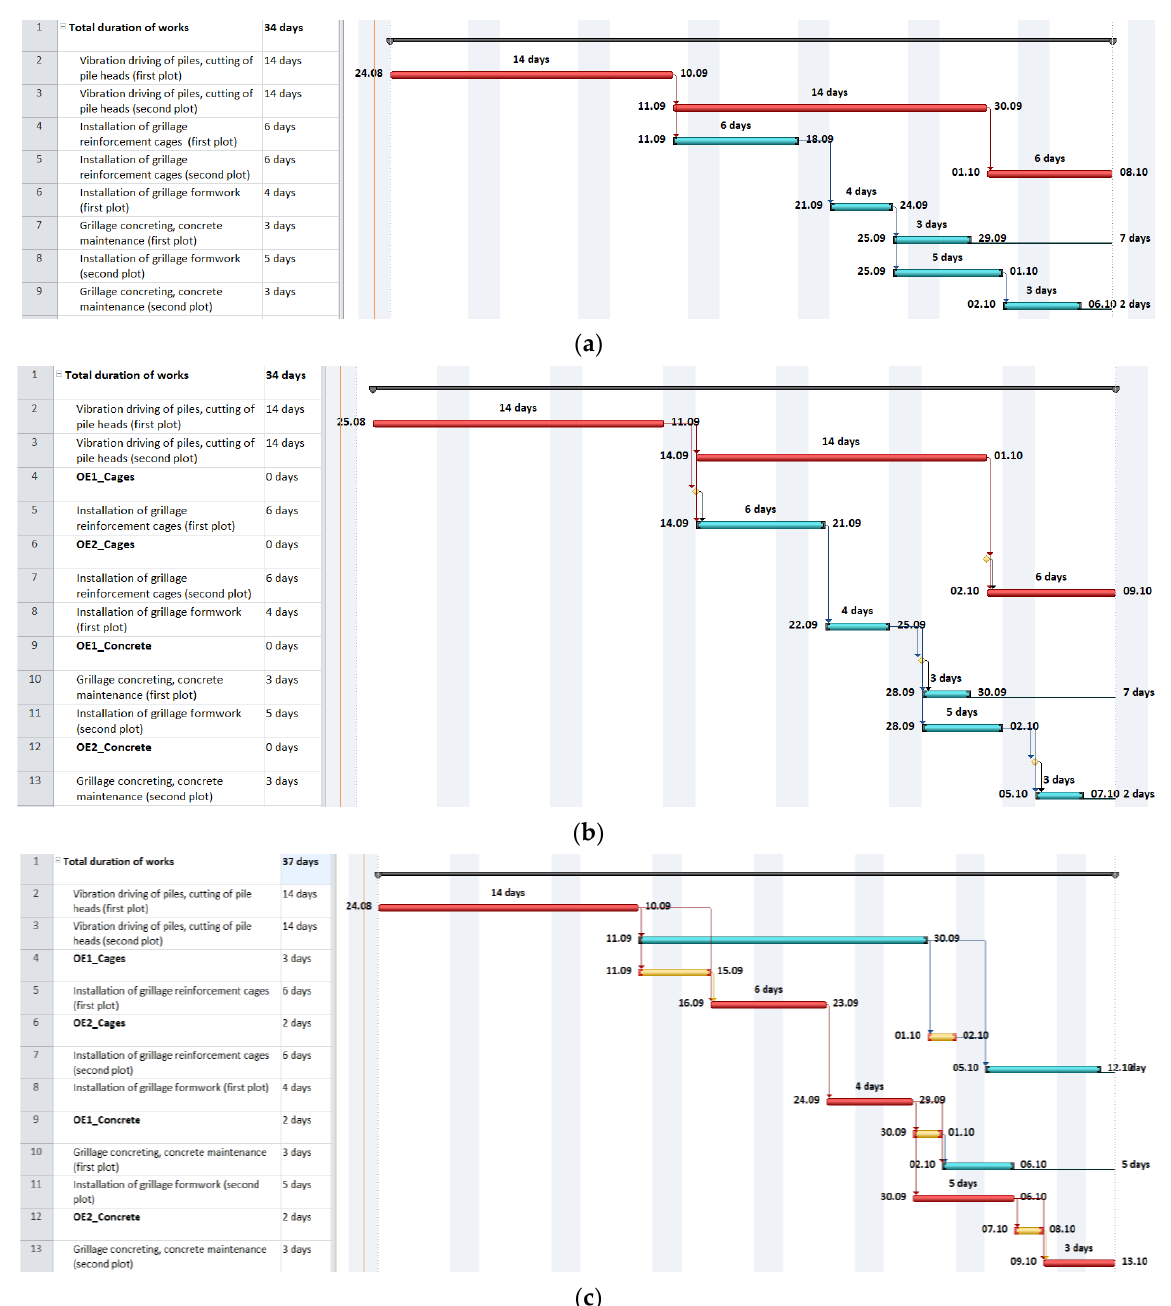
Figure 4. Options of a schedule model that has interruptions: critical path work is in red, normal work that has slacks is in blue, and interruptions are in yellow; schedule without interruptions ( a ), introducing into schedule the fictitious interruptions with zero durations ( b ), schedule variant with non-zero durations of interruptions ( c ).